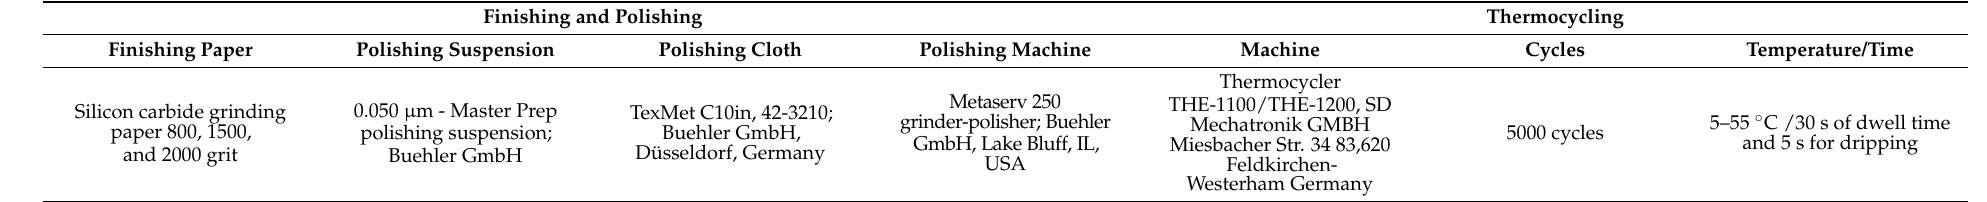
Table 2. Finishing, polishing and thermo-cycling equipment and